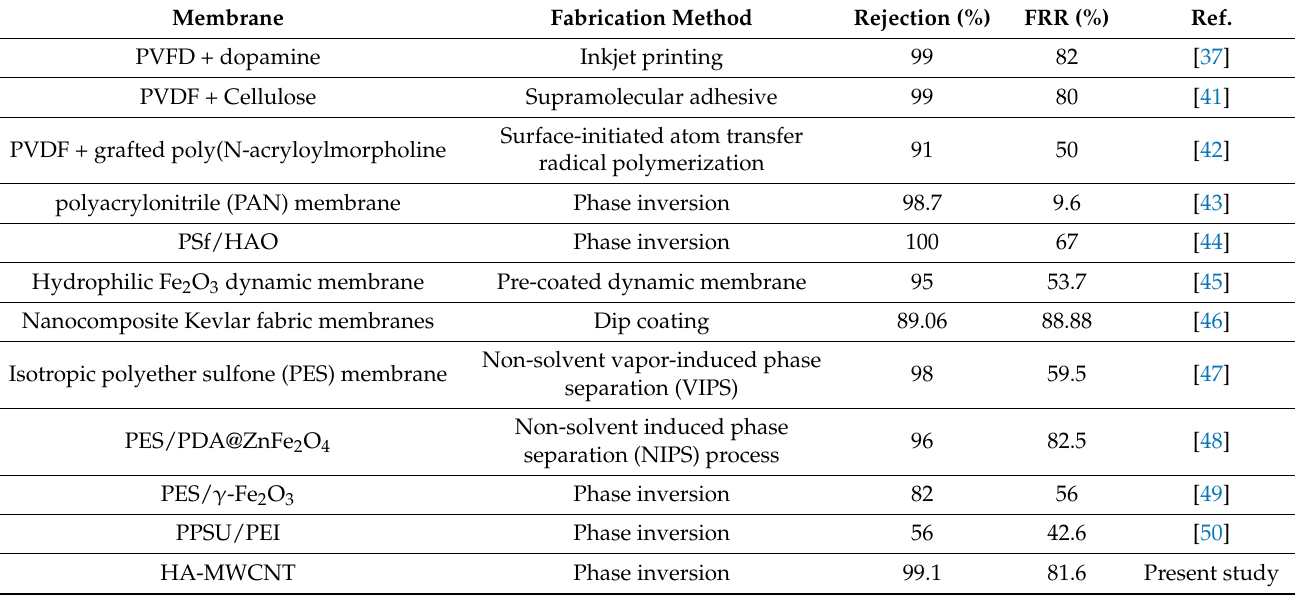
Figure 10. Flux recovery ratio on the HA-MWCNT membrane while separating 200 ppm of oil-in- water emulsions. Table 1. Performance comparison of the HA-MWCNT membrane with previously reported membranes.